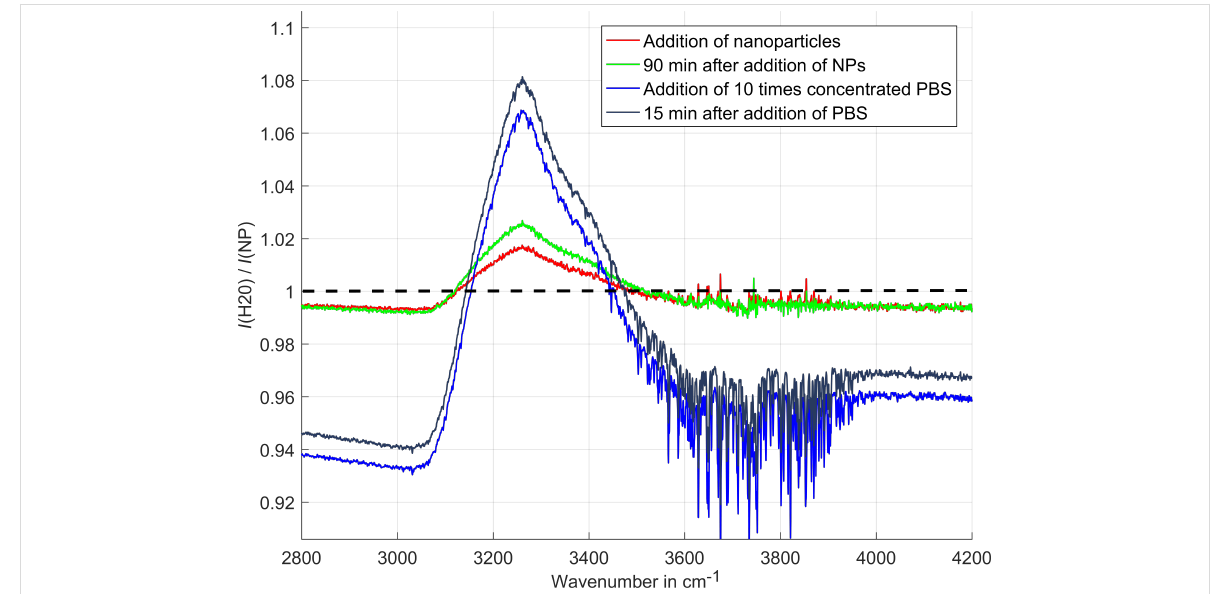
Figure 1: Amplification of water OH-stretching band (measurements with the Teflon